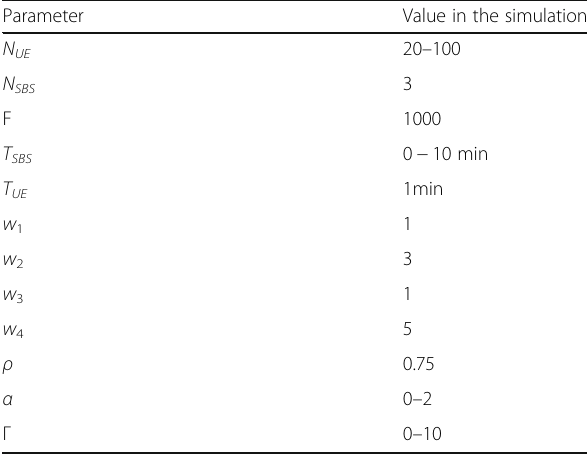
Table 1 Simulation parameters